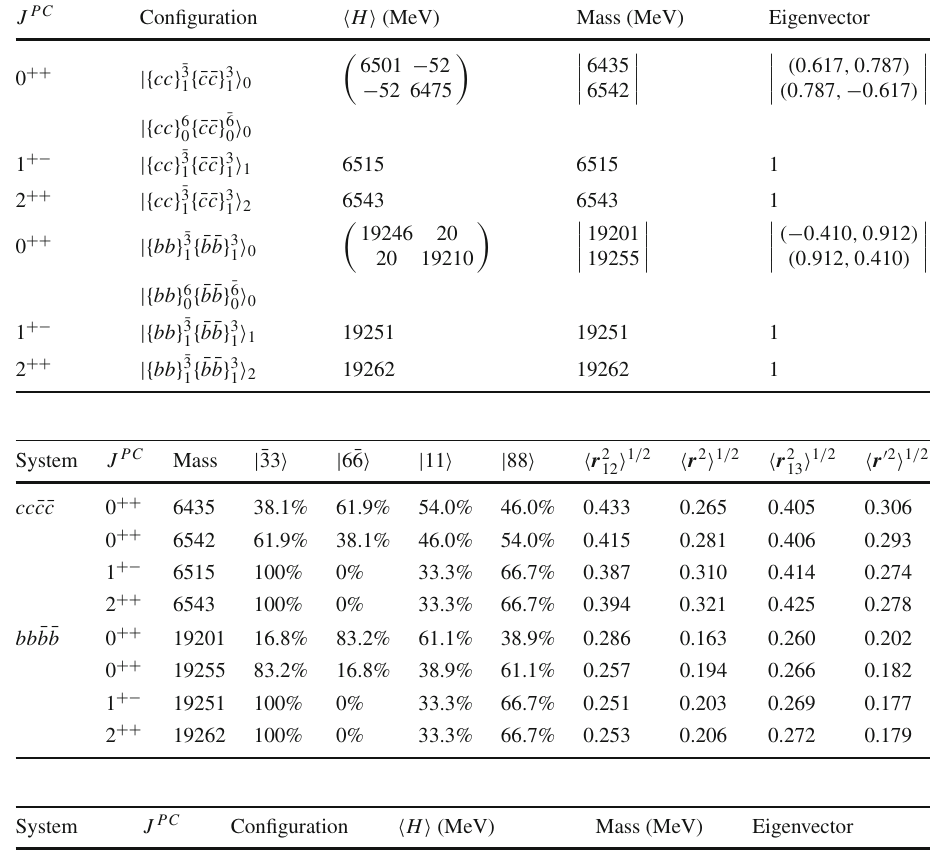
Table 2 Predicted masses of the ground states for cc ¯ c ¯ c and